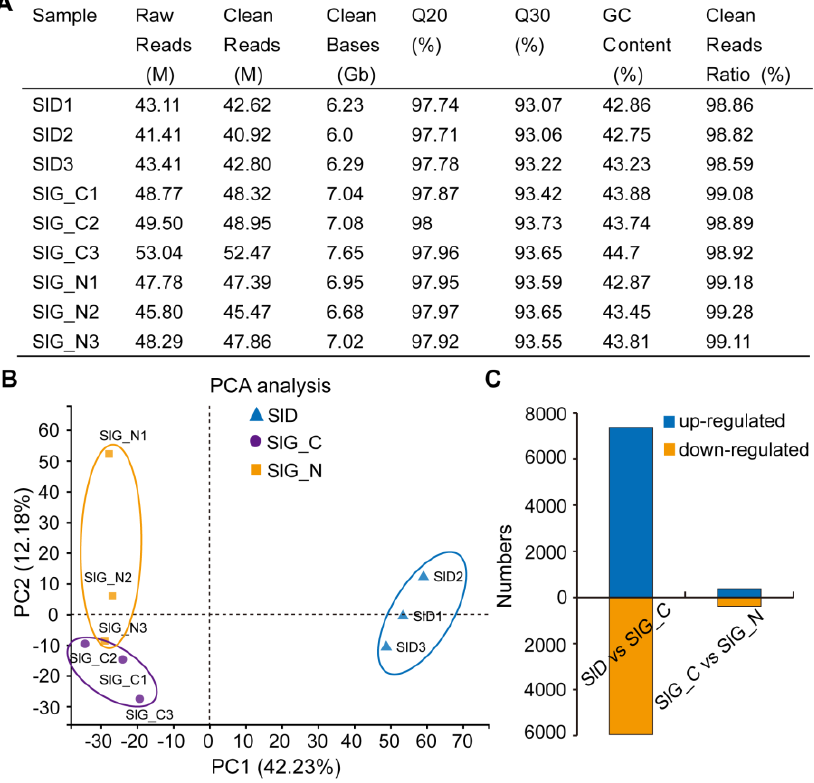
Figure 3. Summary statistics of the transcriptome of SlD, SlG_C, and SlG_N in S. liaotungensis . ( A ) Transcriptome assembly and annotated statistics. GC is short for guanine-cytosine. ( B ) PCA (principal component analysis) of three duplicate samples from SlD (blue), SlG_C (purple), and SlG_N (orange) group. ( C ) The numbers of up-regulated (blue) and down-regulated (orange) genes in the SlD vs. SlG_C and SlG_C vs. SlG_N groups.